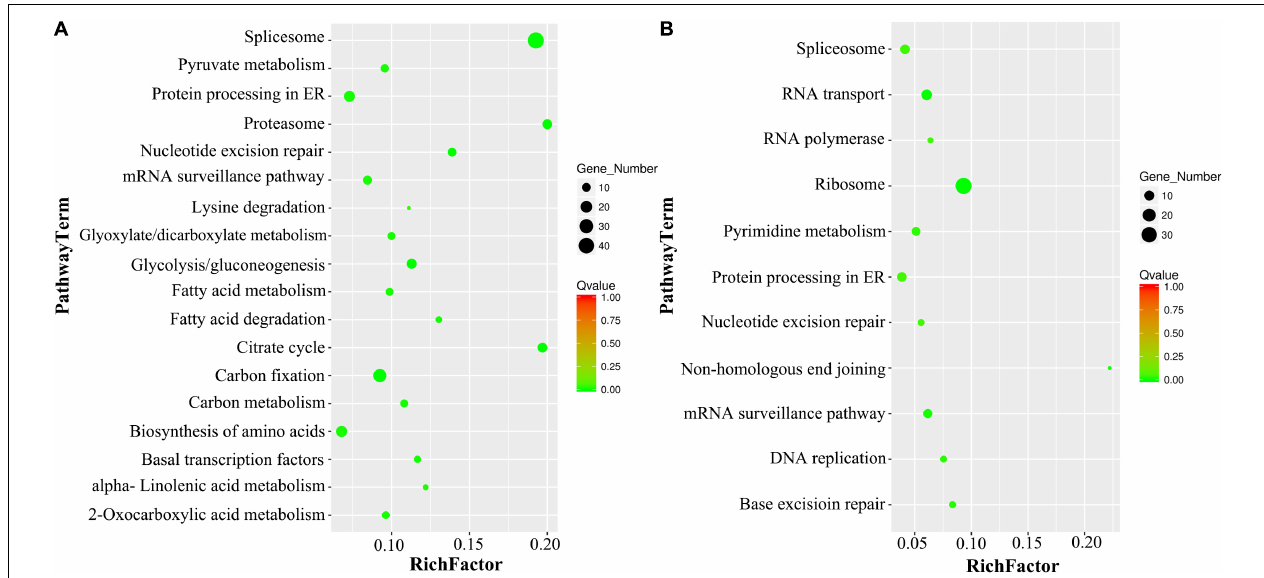
FIGURE 5 | KEGG pathway enrichment analysis of DAPs in VN and GN. (A) The scatter diagram of the top 18 statistics from KEGG pathway enrichment in VN. (B) The scatter diagram of the top 11 statistics from KEGG pathway enrichment in GN. The Q -value must be < 0.05, and the Rich factor positively correlates with the degree of